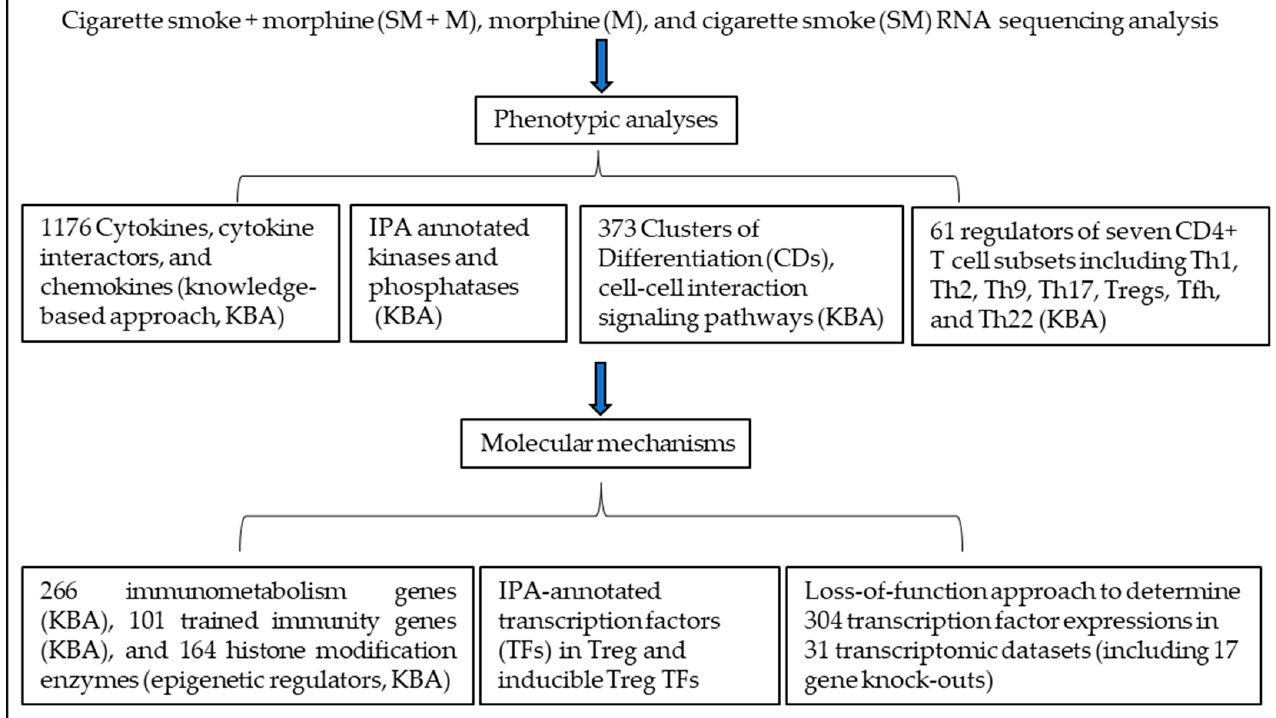
Figure 1. The logic flow of knowledge based analysis (KBA) plus ingenuity pathway analysis (IPA) of Treg transcriptomics modulated in three groups of Tregs: cigarette smoke (SM) Tregs, morphine (M) Tregs, and cigarette smoke plus morphine (SM + M) Tregs includes two parts: (I) phenotypic analysis including 1176 cytokines and their interactors and chemokines (KBA), IPA annotated kinases and phosphatases (KBA), 373 clusters of differentiation (CDs), cell–cell interaction signaling pathways (KBA), 61 regulators of seven CD4 + T cell subsets including Th1, Th2, Th9, Th17, Tregs, Tfh, and Th22 (KBA); (II) molecular mechanisms including 266 immunometabolism genes (KBA), 101 trained immunity genes (KBA), and 164 histone modification enzymes (epigenetic regulators, KBA), IPA annotated transcription factors in Treg and inducible Treg TFs, and loss of function approach to determine 304 transcription factor expressions in 31 transcriptomic datasets (including 17 gene knockouts).